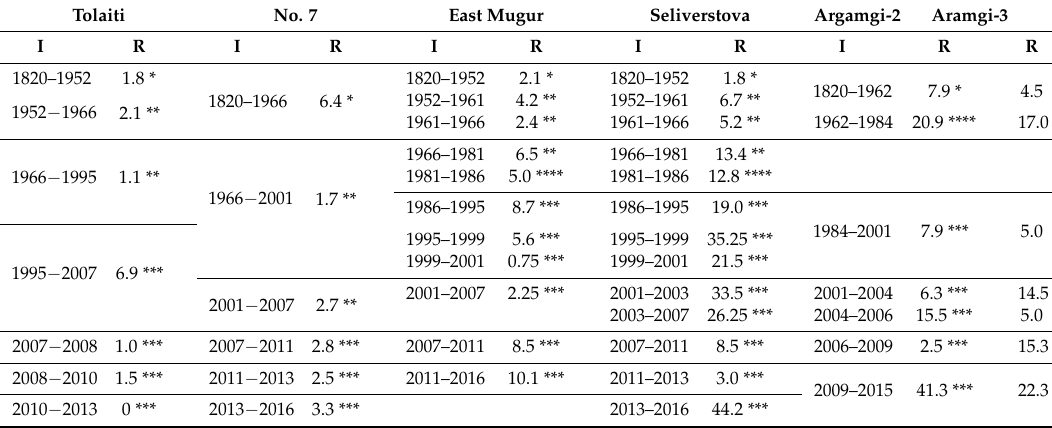
Table 5. The average rates of retreat (m · year − 1 ) of the snout of the Tolaiti Glacier, Glacier No. 7, Seliverstova Glacier, East Mugur Glacier (Mongun-Taiga), Argamgi-2 Glacier, and Aramgi-3 Glacier (Tavan